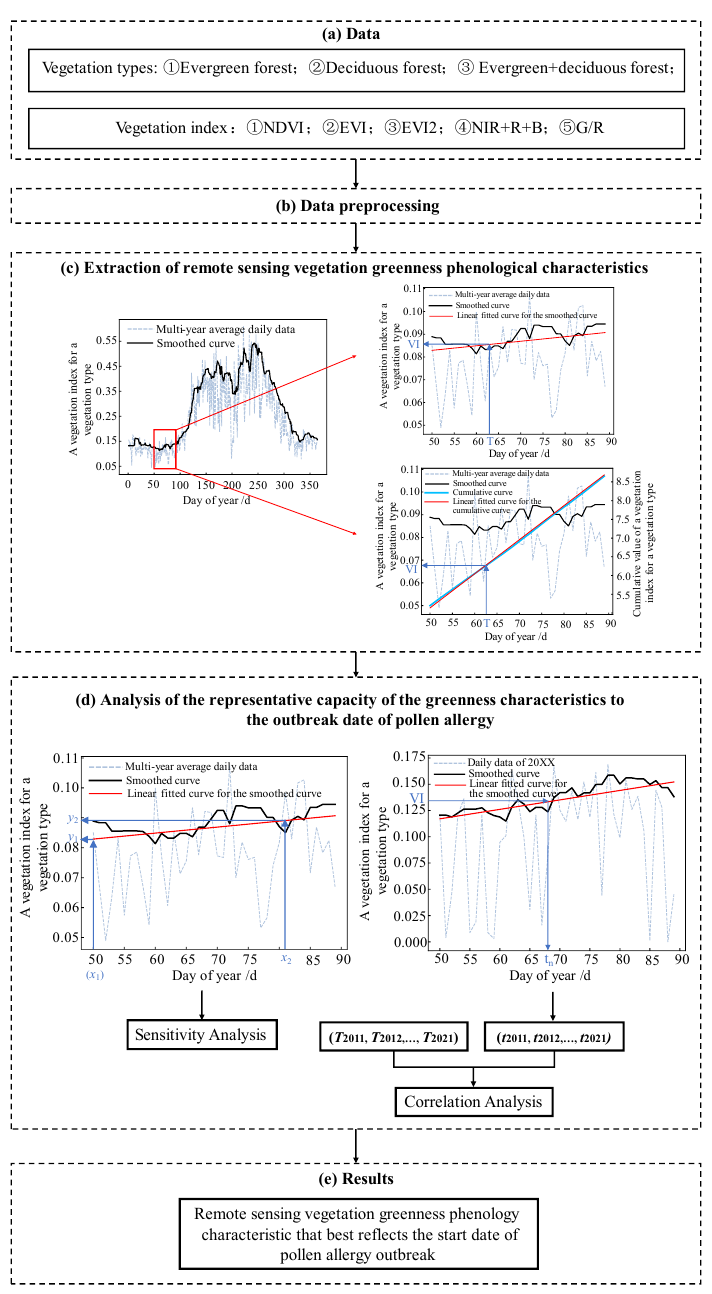
Figure 2. Technical process diagram for the extraction of satellite-derived vegetation greenness phenological characteristics before the pollen allergy outbreak. T in the right plots of ( c ) is the average DOY of spring pollen allergy outbreak during 2011–2021; VI in the right plots of ( c ) and ( d ) is the vegetation index value corresponding to the average DOY of pollen allergy outbreak; x 1 in the left plot of ( c ) is the DOY that 20 days earlier than the earliest breakout date of spring pollen allergy during 2011–2021, i.e., the 50th day; x 2 is the average DOY of spring pollen allergy outbreak during 2011–2021, i.e., the 81st day; y 1 is the vegetation index value corresponding to x 1 on the fitted curve of the smoothed multiyear average daily curve of a vegetation index for a vegetation type; y 2 is the vegetation index value corresponding to x 2 on the fitted curve of the smoothed multiyear average daily curve of a vegetation index for a vegetation type; t n in the right plot of ( d ) is the corresponding DOY of VI in each year during 2011–2021; and T n is the DOY of spring pollen allergy outbreak in each year during